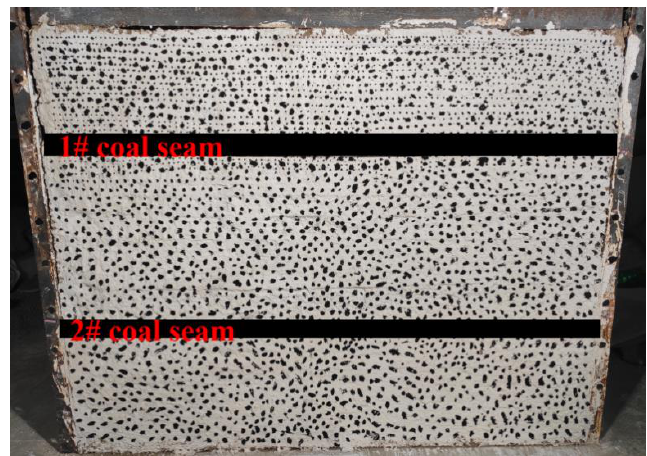
Figure 15. Similarity simulation model.